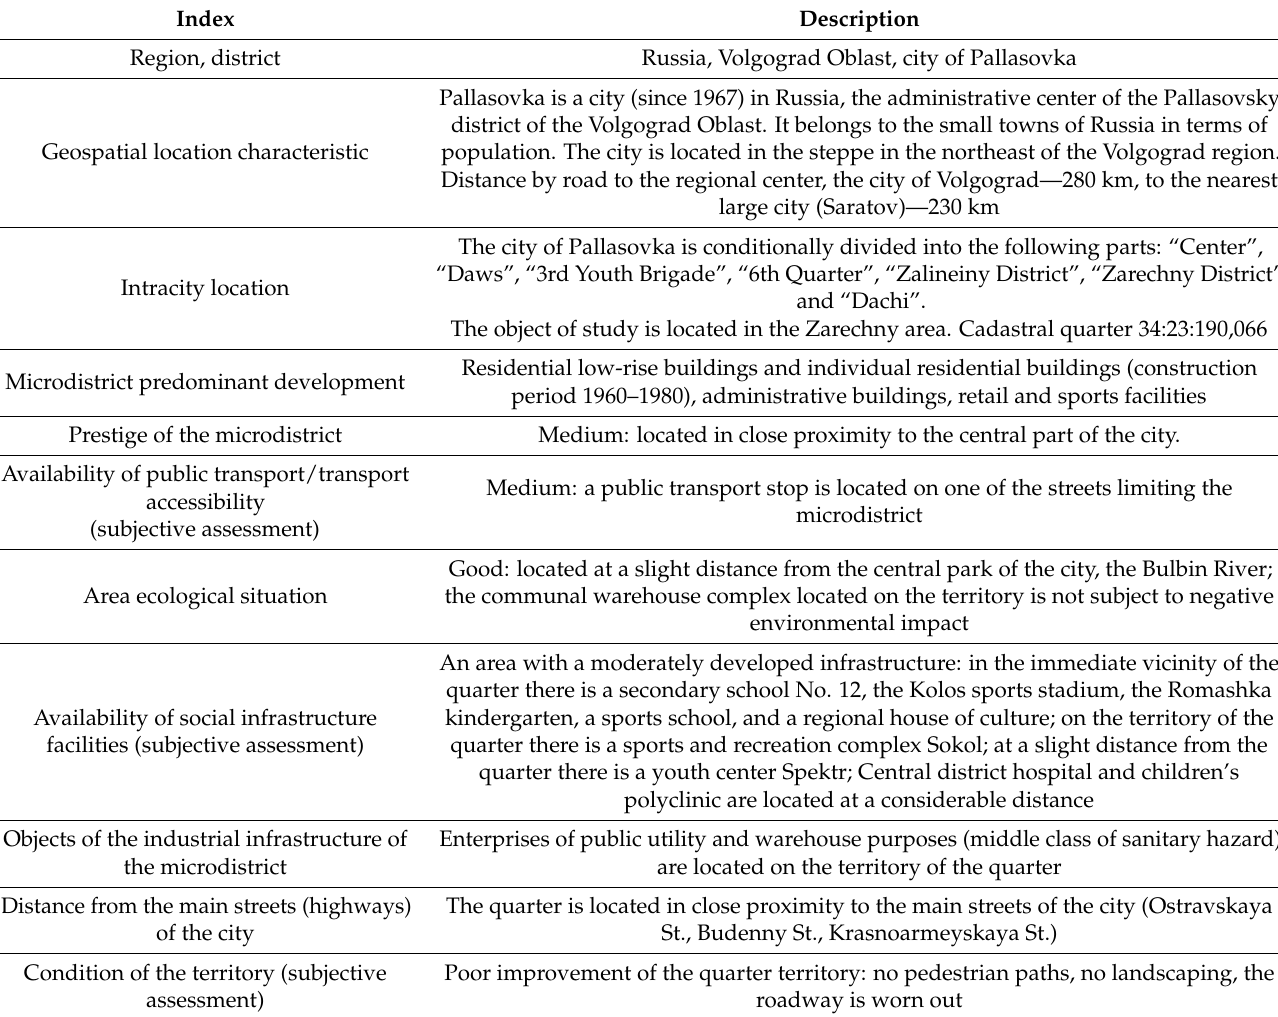
Table 3. Description of the object of